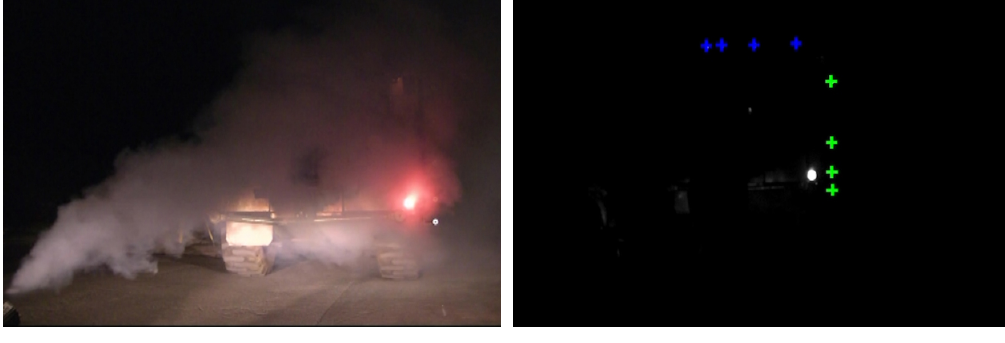
Figure 33. Both targets’ models are identified and tracked despite heavy interfering light.